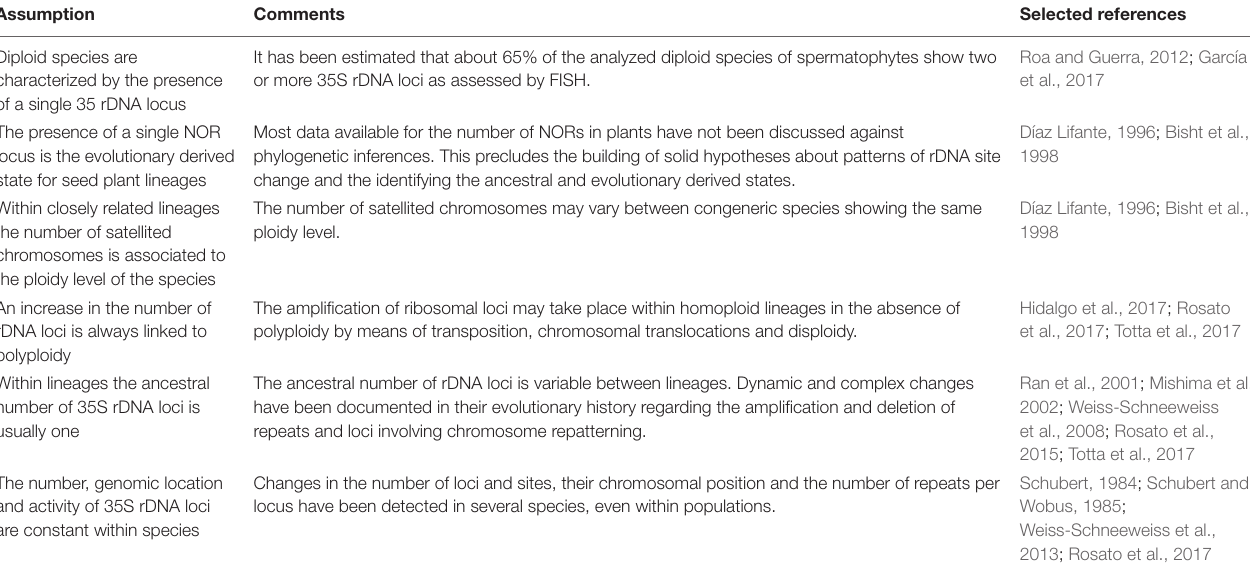
TABLE 3 | Evolutionary trends in the number and activity of rDNA and NOR loci: cautions and limitations. Assumption